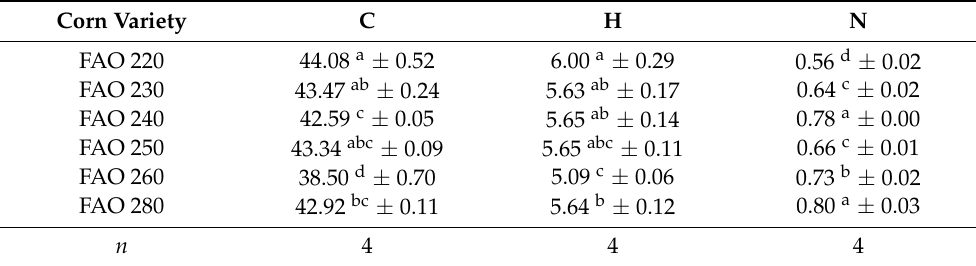
Table 4. Elemental composition of cob cores depending on the FAO earliness pattern. Corn